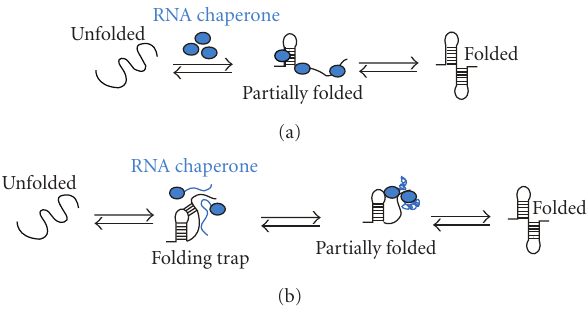
Figure 3: Hypothetical mechanisms of RNA chaperoning. (a) shows folding of an RNA molecule in the presence of RNA chaperones (blue). RNA chaperones and proteins with RNA chaperone activity prevent the RNA from misfolding and increase annealing of the correct structure by crowding. (b) Proteins with RNA chaperone activity possessing disordered regions (blue) interact with mis- folded RNA. Upon energy transfer, the RNA structure loosens and the disordered protein domain becomes more ordered. Proteins with RNA chaperone activity are dispensable in both cases after the RNA has folded into its native